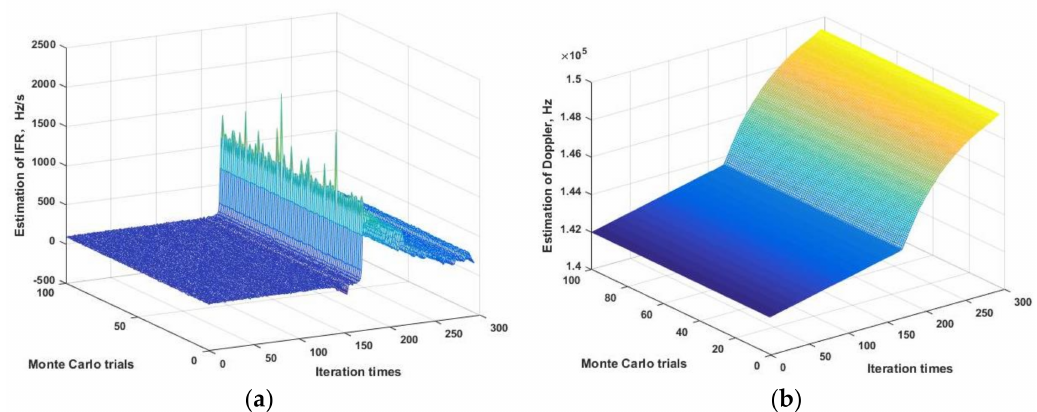
Figure 22. Simulation results of an IFR tracking approach for parachute deployment at CNR = 29 dB-Hz: ( a ) Doppler rate; ( b ) Doppler